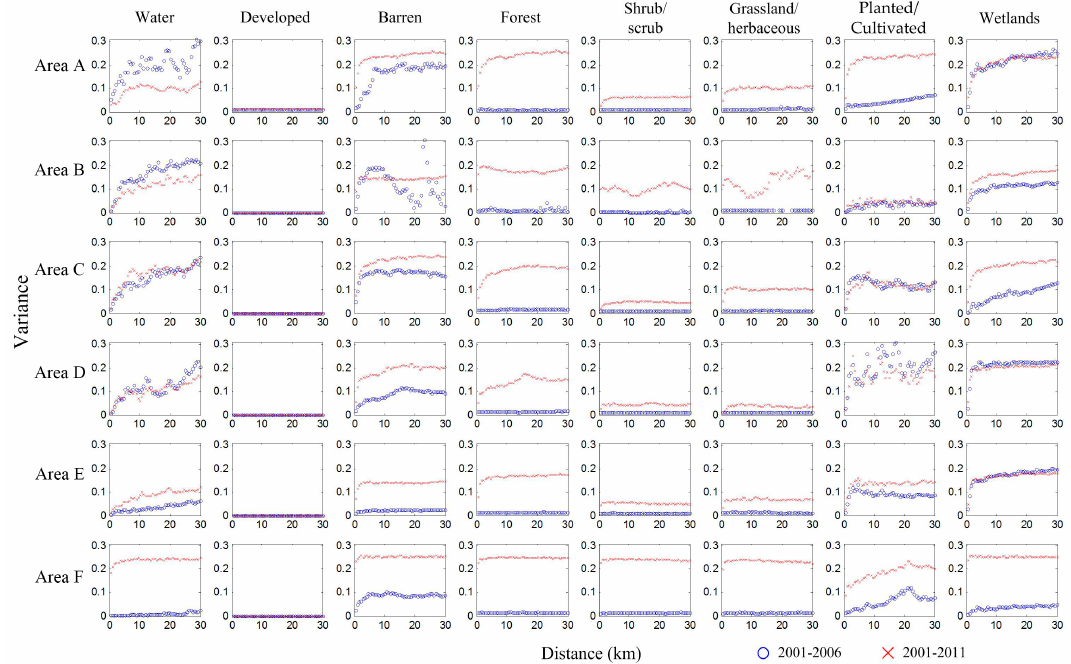
Figure 9. The variance values for the six study areas during 2001–2006 and 2001–2011 with different land cover classes in the eight-class scheme.